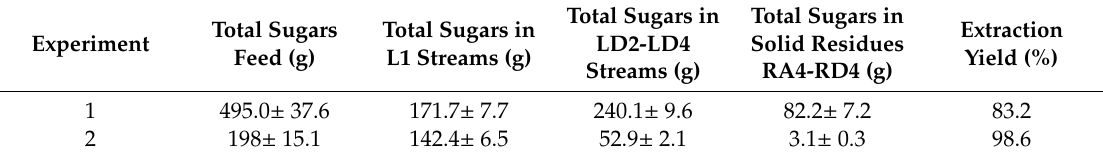
Table 4. Counter-current experiments results.